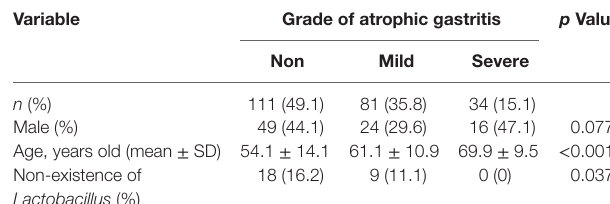
TaBle 2 | Subject characteristics according to grade of atrophic gastritis.